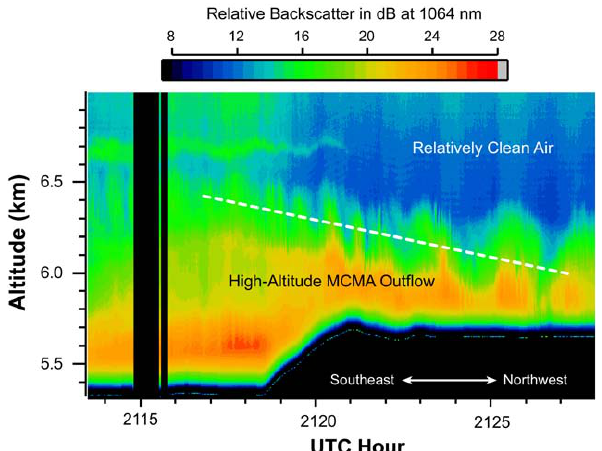
Fig. 15. SABL image of what may be the upper portion of the MCMA residual mixed layer approximately one day after it left Mexico City. The slope (white dashed line) approximately matches the shear seen in the balloon-based trajectories. Urban tracer concentrations (notably MTBE) peak along the entire high-altitude portion of the flight track (after 21:20 UTC to the right).